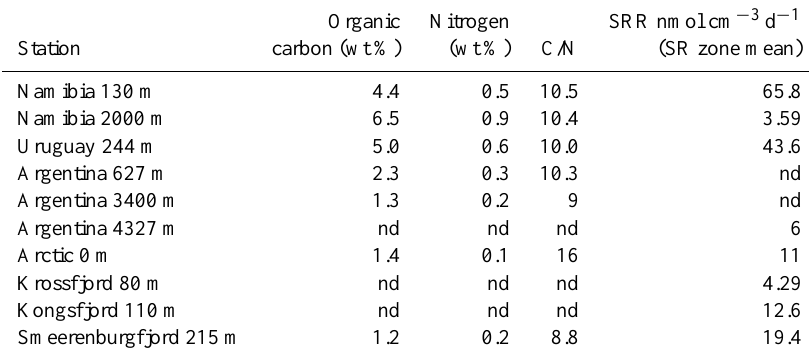
Table 2. Bulk geochemical analysis. Carbon and nitrogen concentrations determined for Namibian, Uruguayan, Argentine and Arctic sedi-